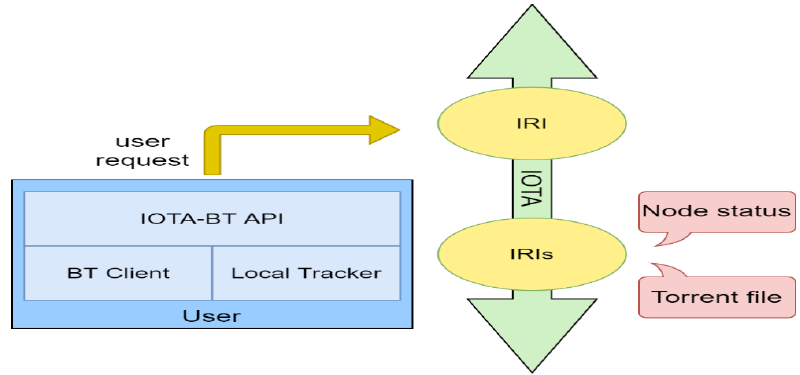
Figure 4. IOTA-BT architecture.